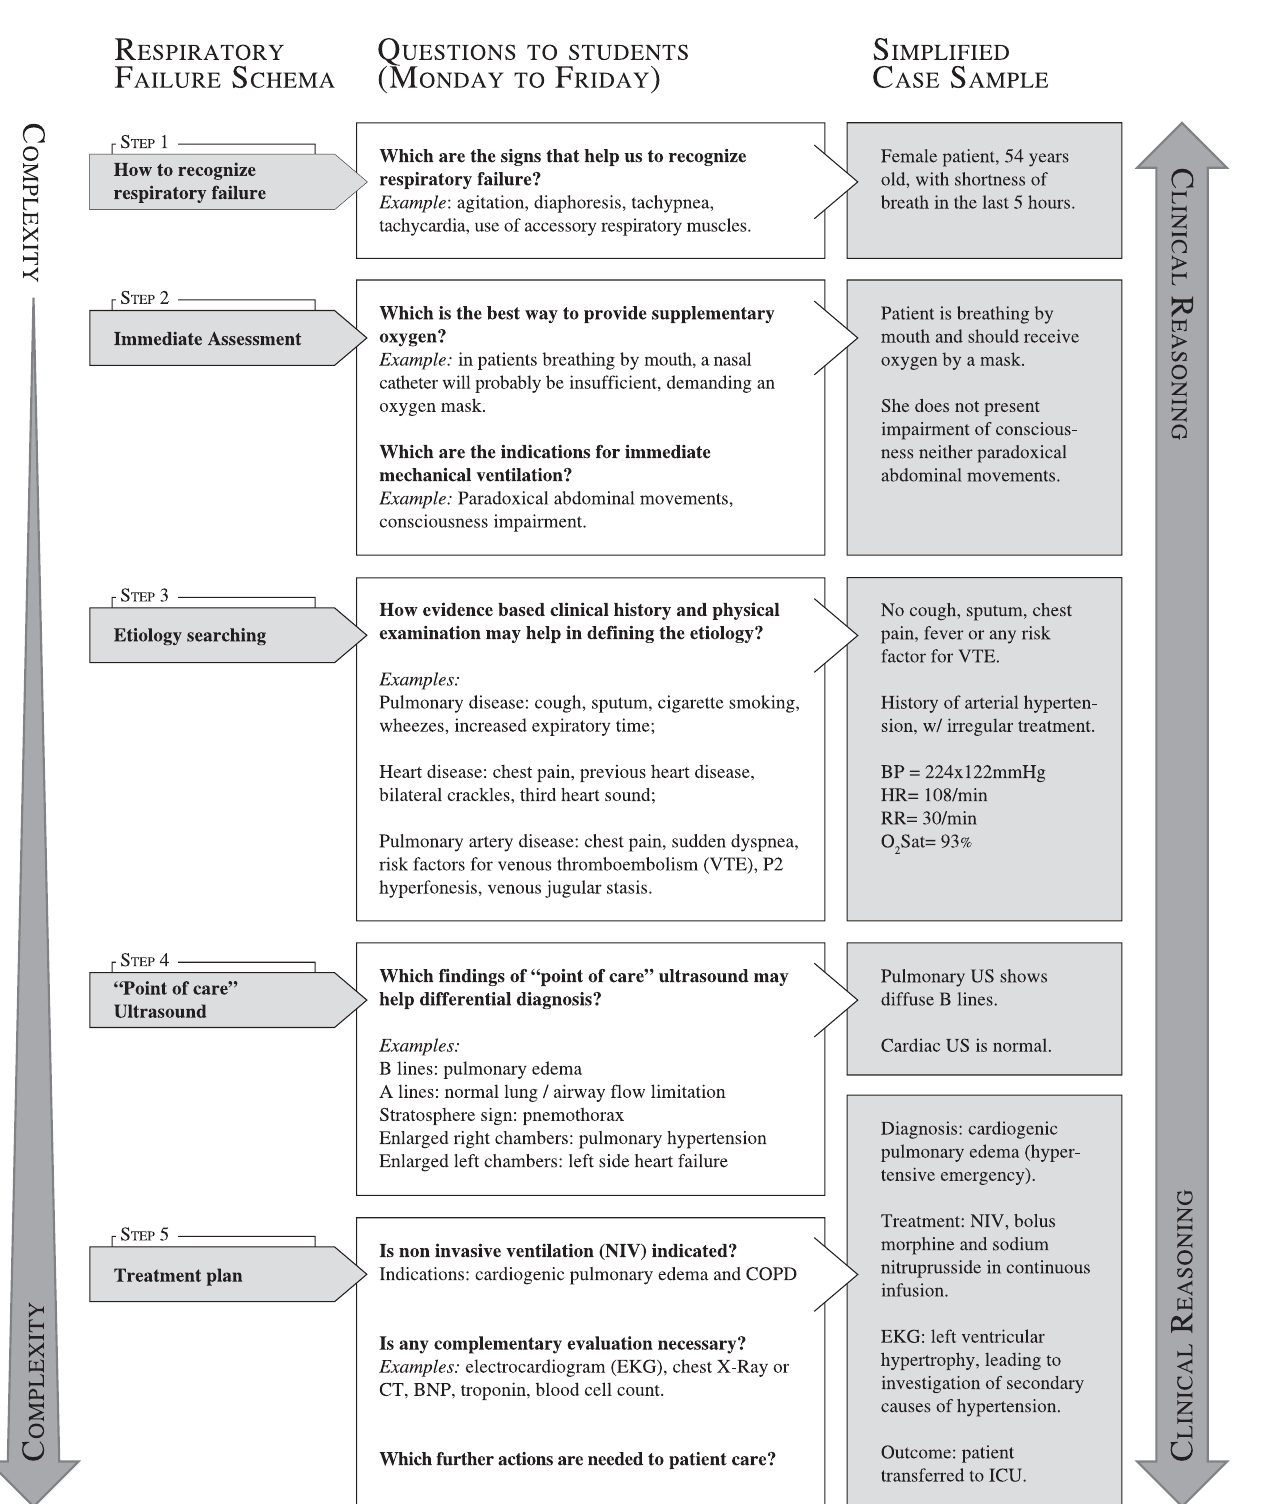
PLOS ONE | DOI:10.1371/journal.pone.0152462 March 31,